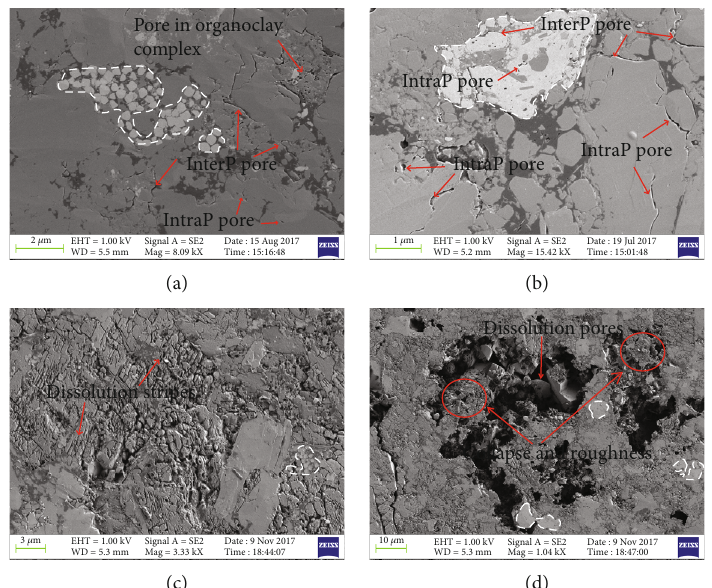
Figure 4: Field emission scanning electron microscope (FE-SEM) images of raw (a, b) and treated (c, d) GZ shale (the white marks are the pyrite location).